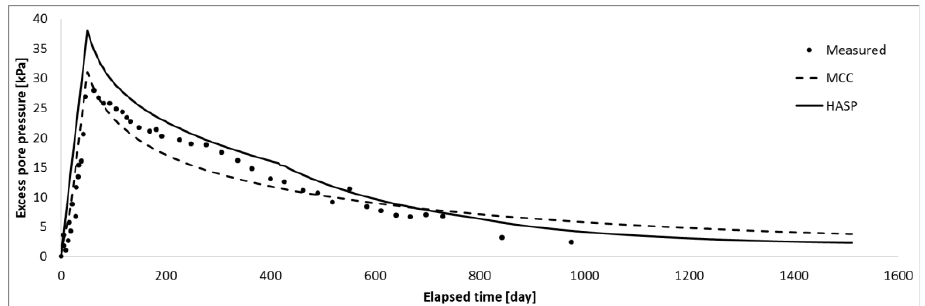
Figure 13. Comparison of excess pore pressure-time curves for Embankment A — Point 𝑃 3 (8.3 m below the surface).